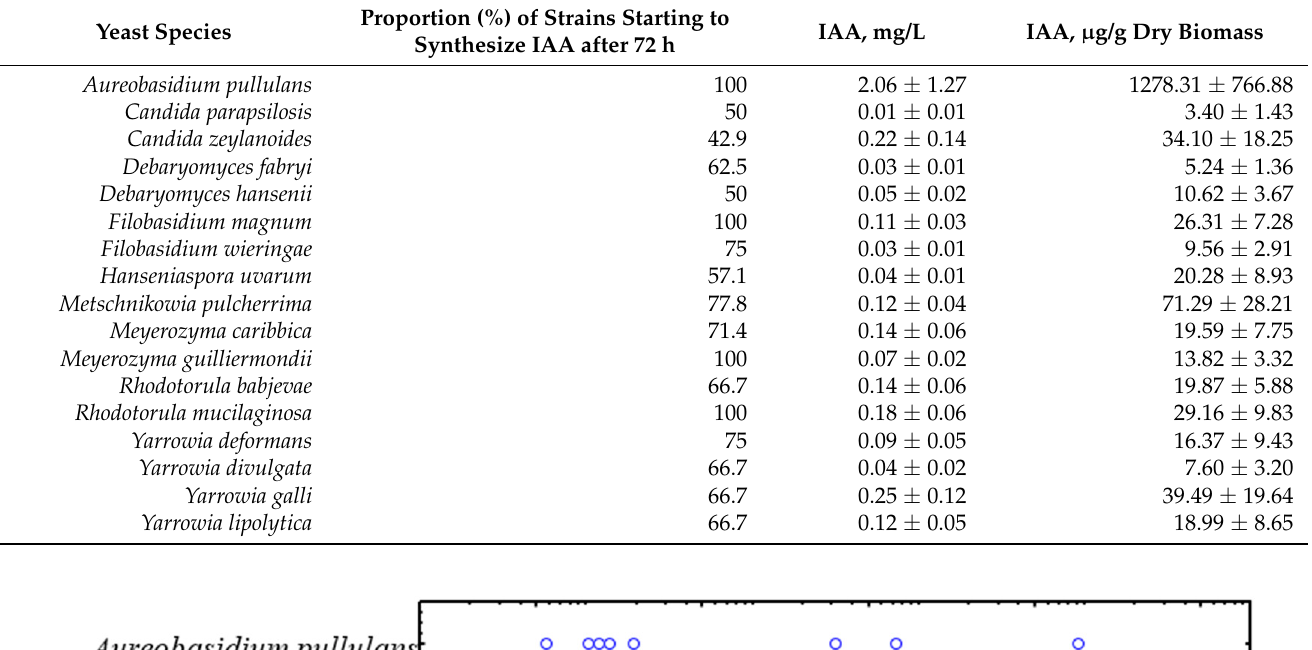
Table 2. Proportion of active strains of the studied endophytic yeast species and average IAA production (with standard deviations) in the culture liquid and per unit biomass.